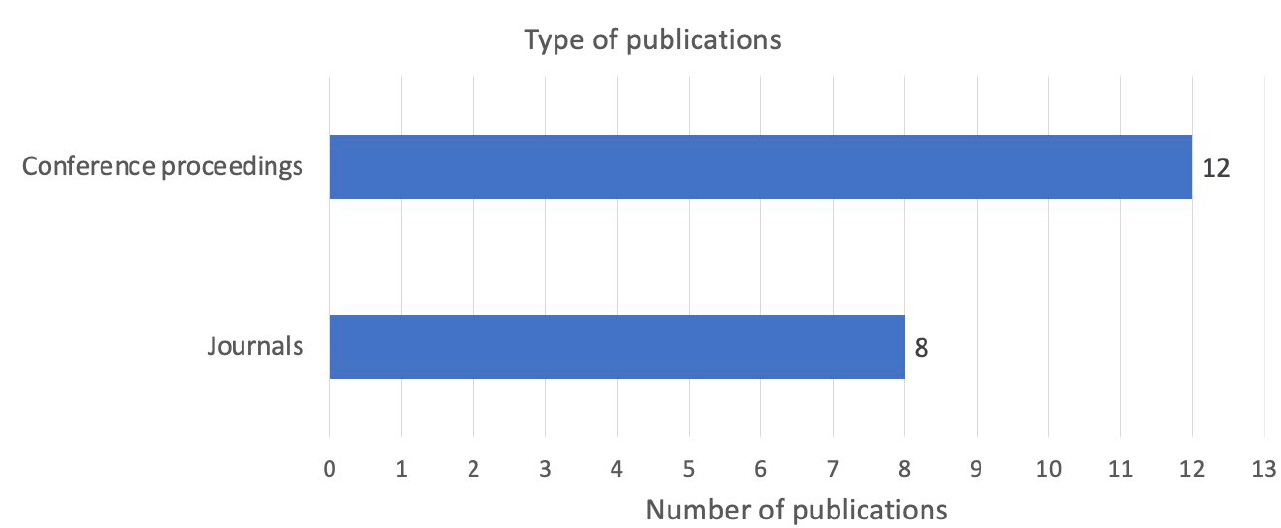
Figure 3. Number of papers per publication type.